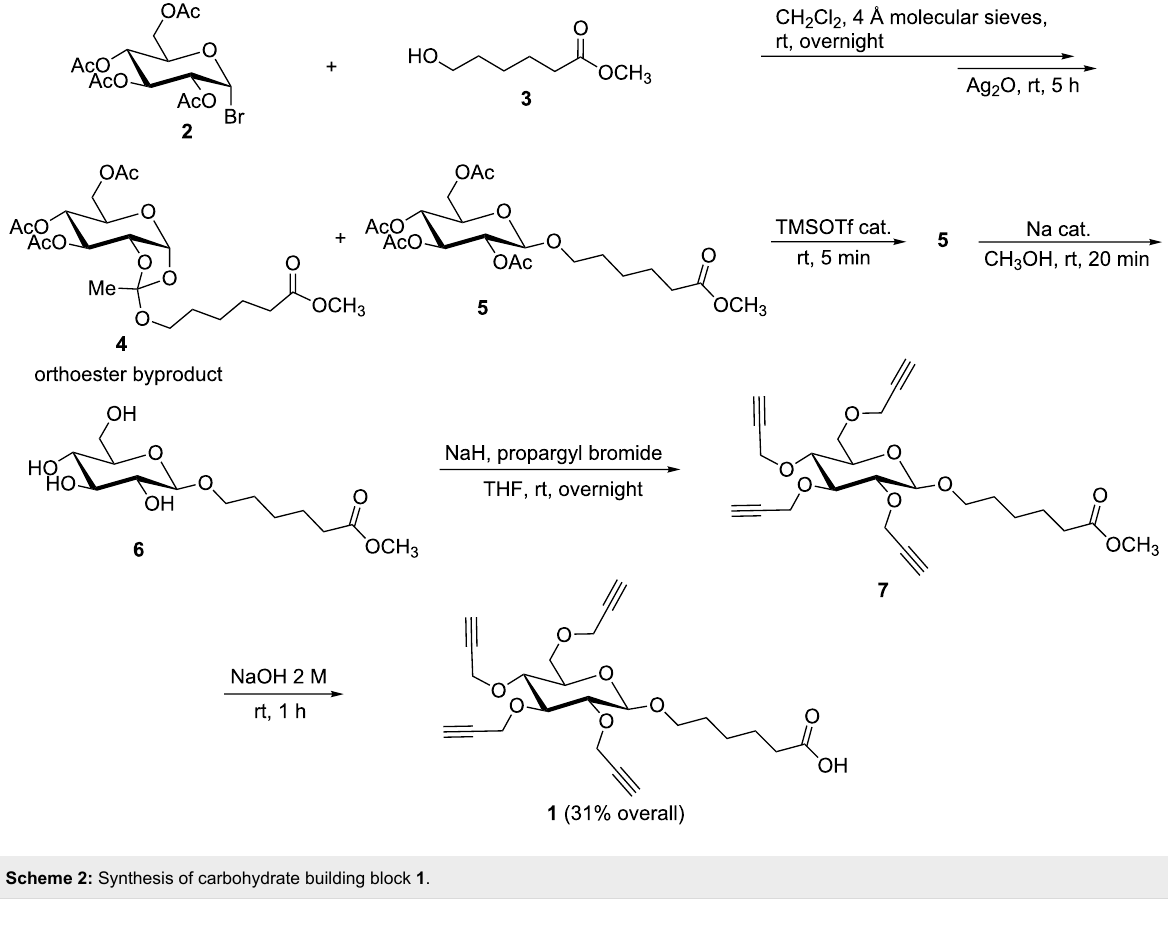
Scheme 2: Synthesis of carbohydrate building block 1